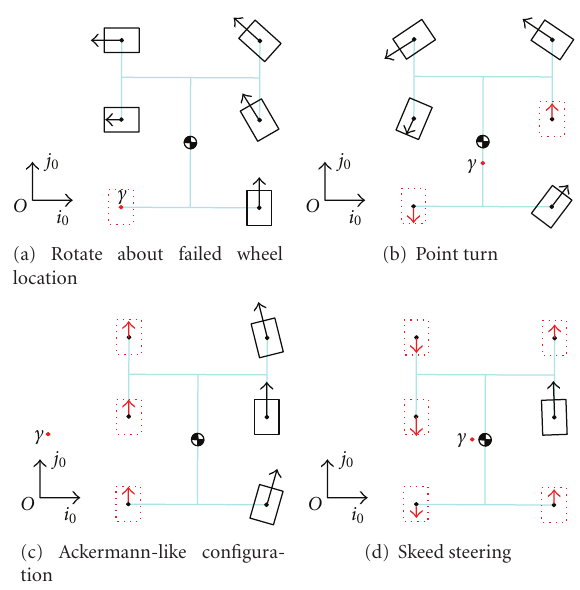
Figure 12: Steering configurations generated by the